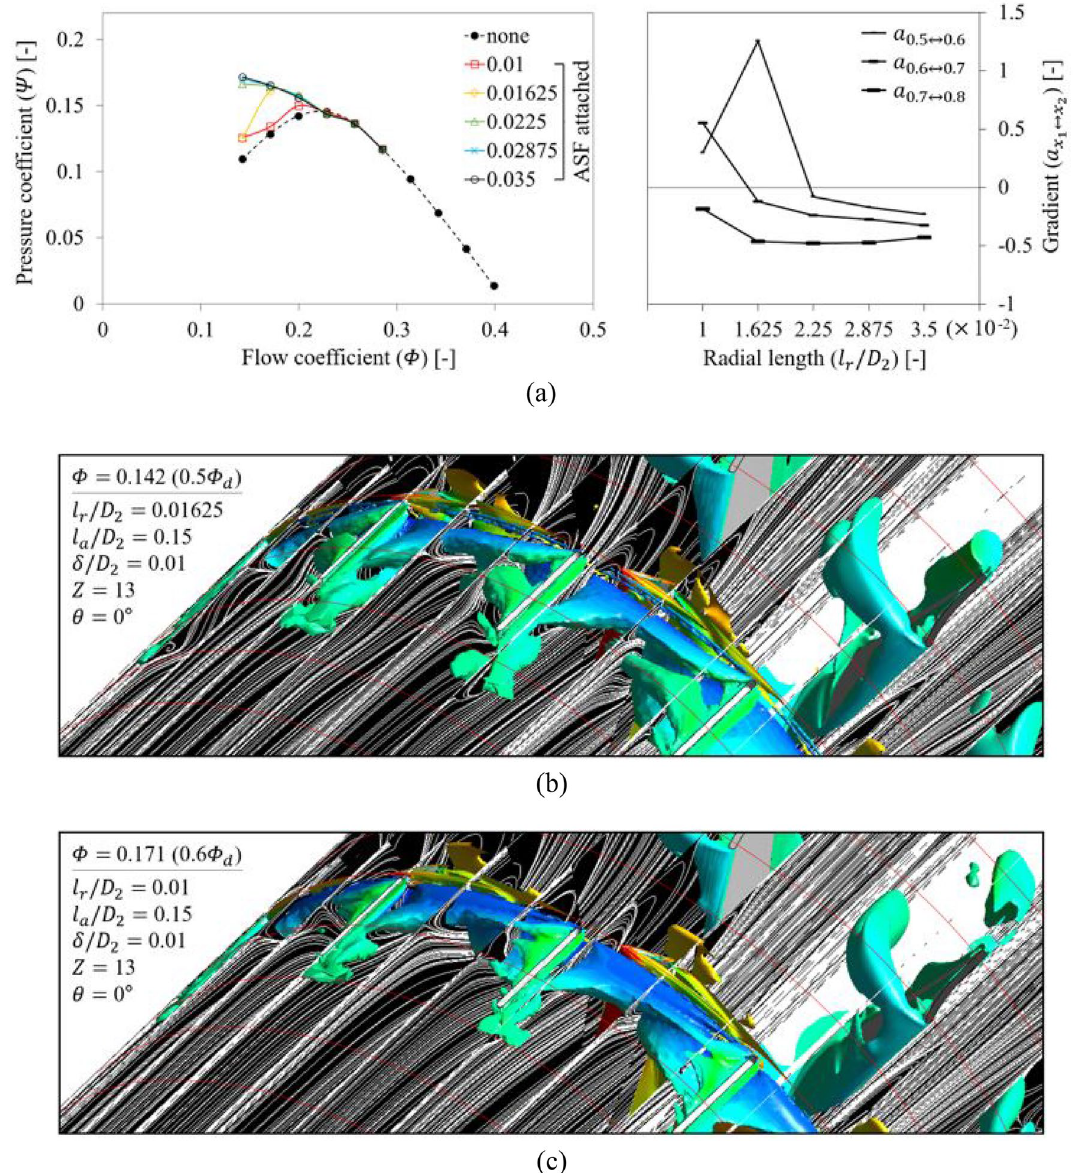
range; ( b ) Internal flow field for l r / D 2 = 0.01625 at 0.5 Φ d ; ( c ) Internal flow field for l r / D 2 = 0.01 at 0.6 Φ d